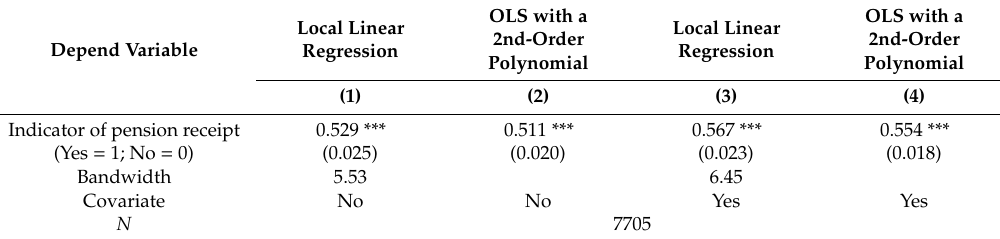
Table 2. First-stage estimates for pension